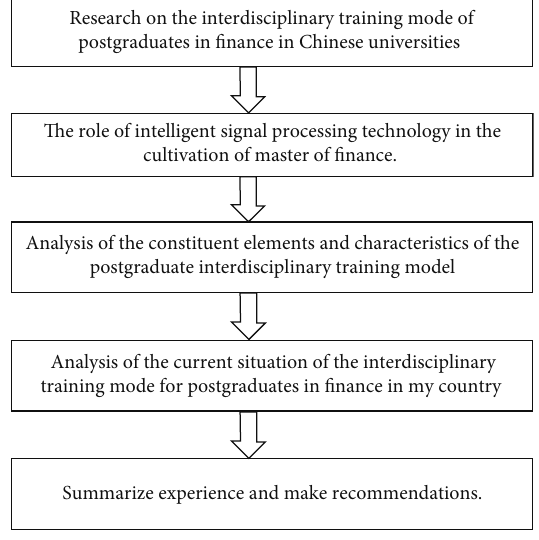
Figure 1: Research technology